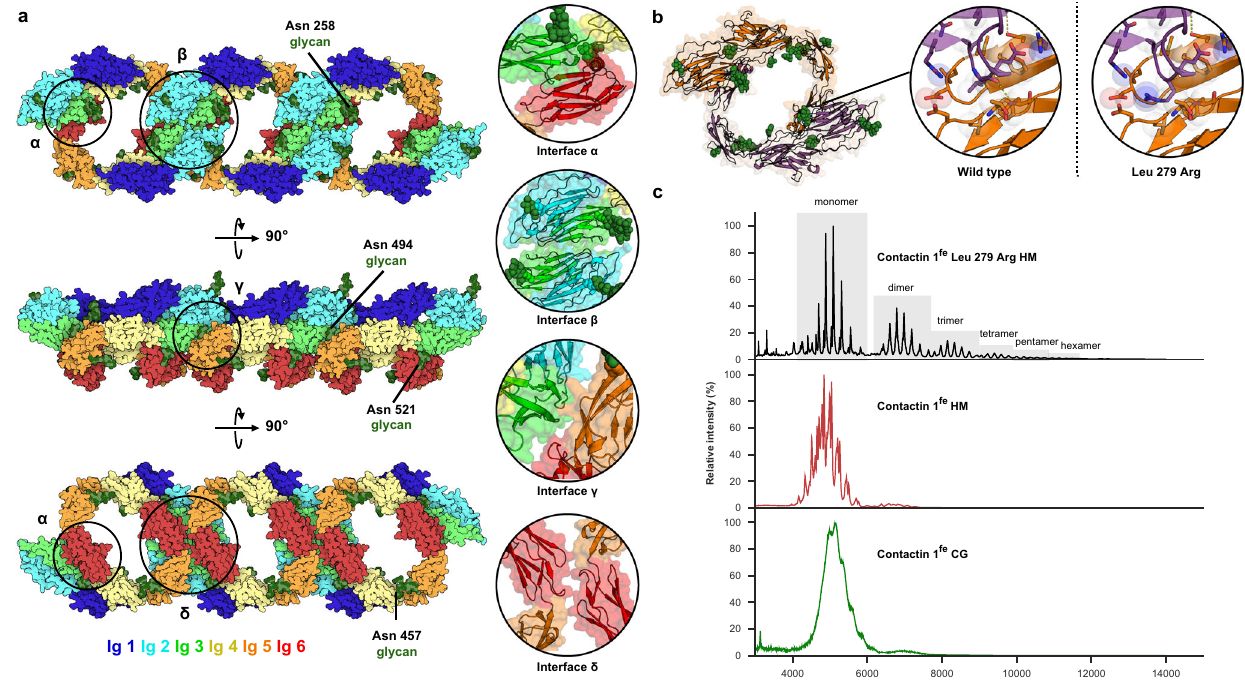
Fig. 4 | A one-dimensional crystallographic contactin 1 Ig1 – 6 zipper and weak propensity of oligomer formation in solution. a Crystallographic contactin 1 Ig1 – 6 zipper with rainbow-colored domains. Interfaces holding molecules together are annotated ( α - δ ), with insets illustrating these contacts. Glycans in proximity of potentialinterfaces areannotated. b Contactin1 Ig1 – 6 dimerfromthezipperburying mostsurfaceareathroughtwo α interfaces.Insetshowdetailsoftheinterfaceanda